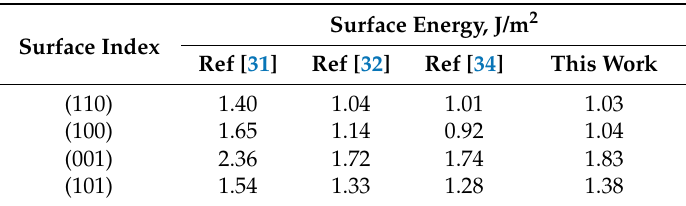
Table 4. Surface energies of four low-index surfaces of SnO 2 obtained by different researchers.